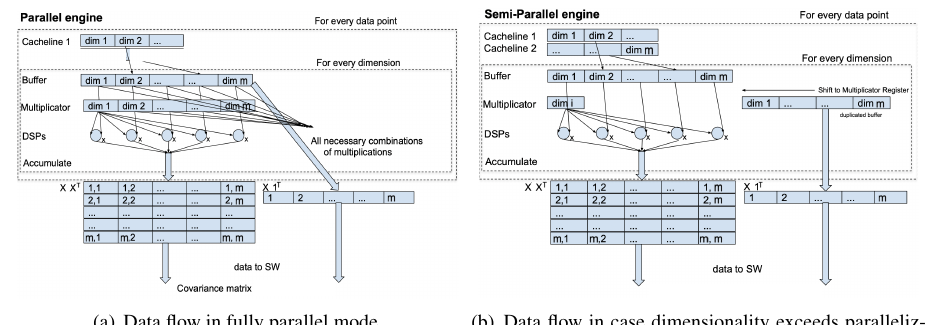
Figure 2. Data flow of the covariance matrix calculation within the FPGA. On the left side, the case is given where all the samples fit into the cache line in one go; on the right side, the case is illustrated where the samples have to be shifted into the multiplier DSP